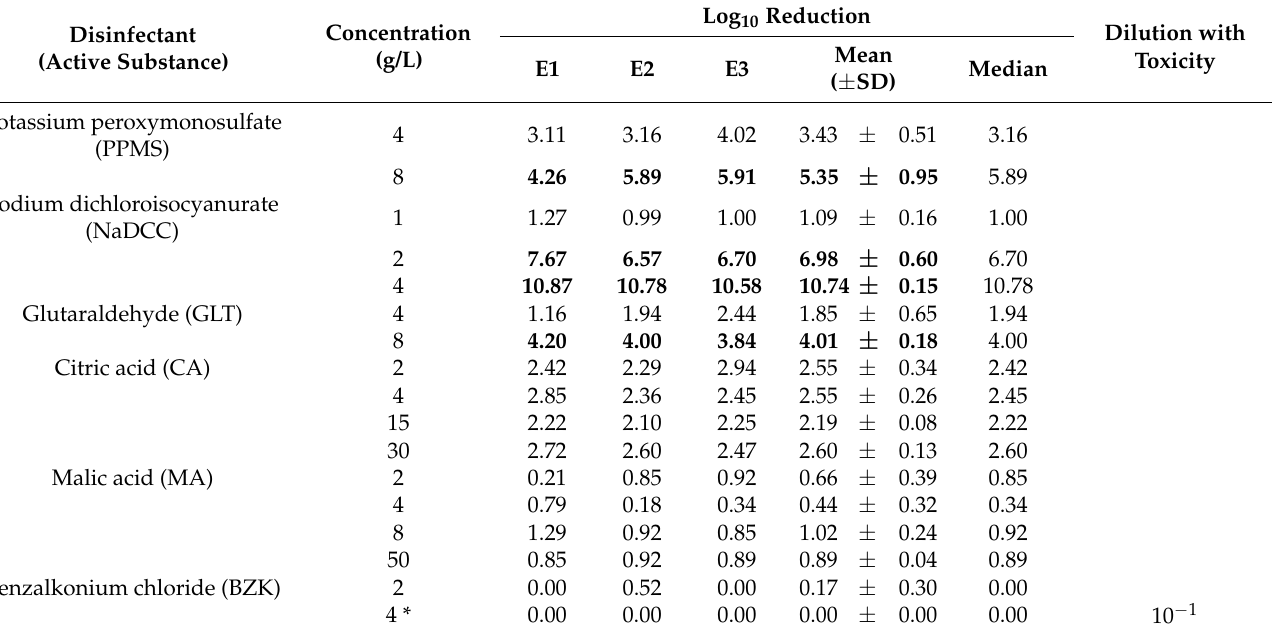
Table 2. Virucidal activity of active substances against bacteriophage